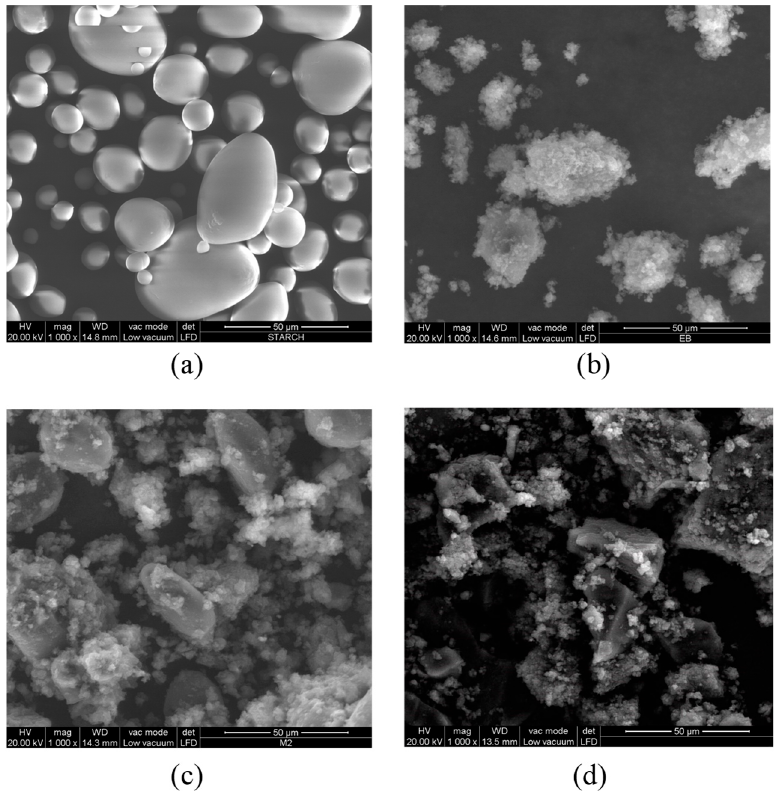
Figure 1. SEM images of ( a ): starch, ( b ) PANI and PANI/starch biocomposites. ( c ): (1:1) and ( d ): (3:1).